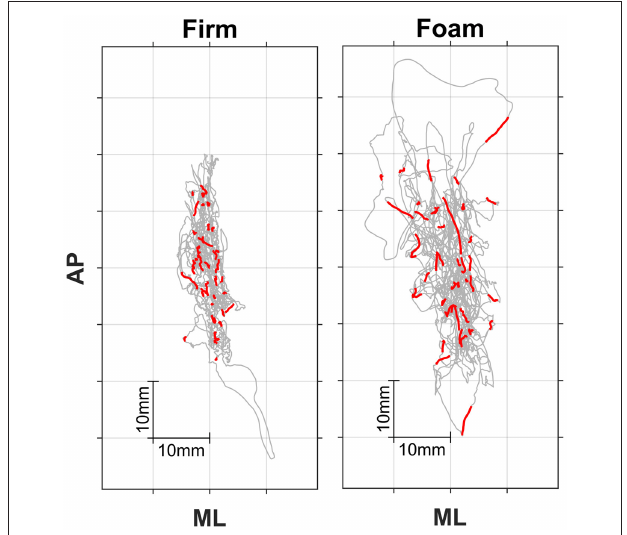
FIGURE 1 | Posturograms for firm (Left) and foam (Right) surface conditions. Trials lasted 181s. Anterior-posterior (AP) vs. mediolateral (ML) center-of-pressure trajectories are depicted in gray, while superimposed red traces represent the 42 or so stimulus-response episodes during a